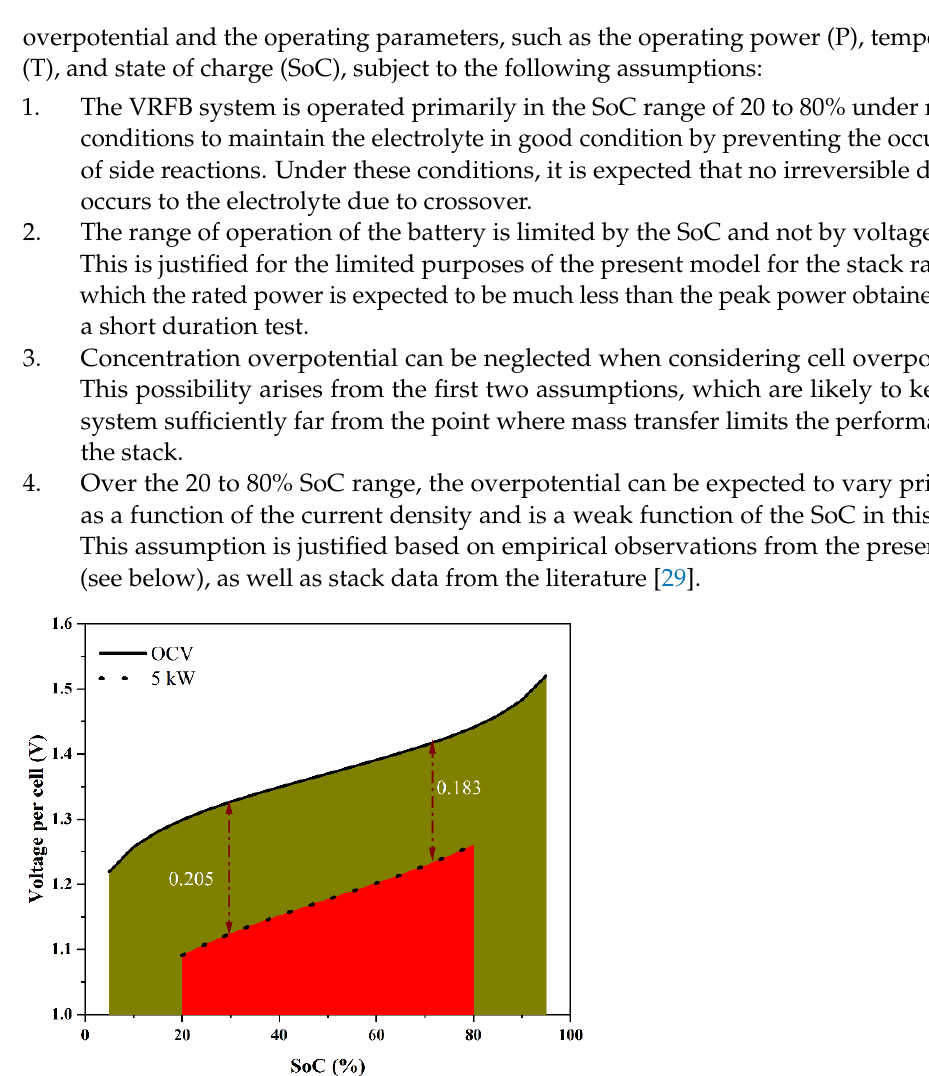
Figure 2. Schematic variation of the open-circuit voltage with the SoC in the range of 5% to 95% and the variation of the voltage per cell of a stack discharging at 5 kW over the SoC range of 80% to 20%. The area under the curve in each case is proportional to the energy discharged over the SoC interval.